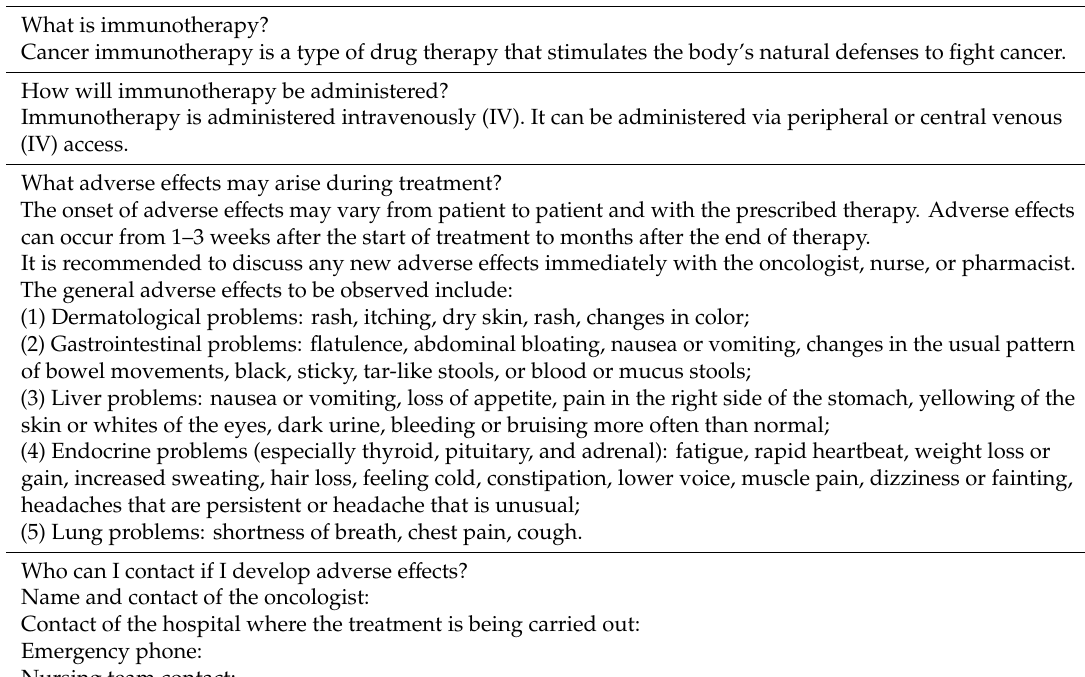
Table 6. Example of an education tool in the field of immunotherapy to be dispensed by pharmacists to patients and family members (adapted from ref.